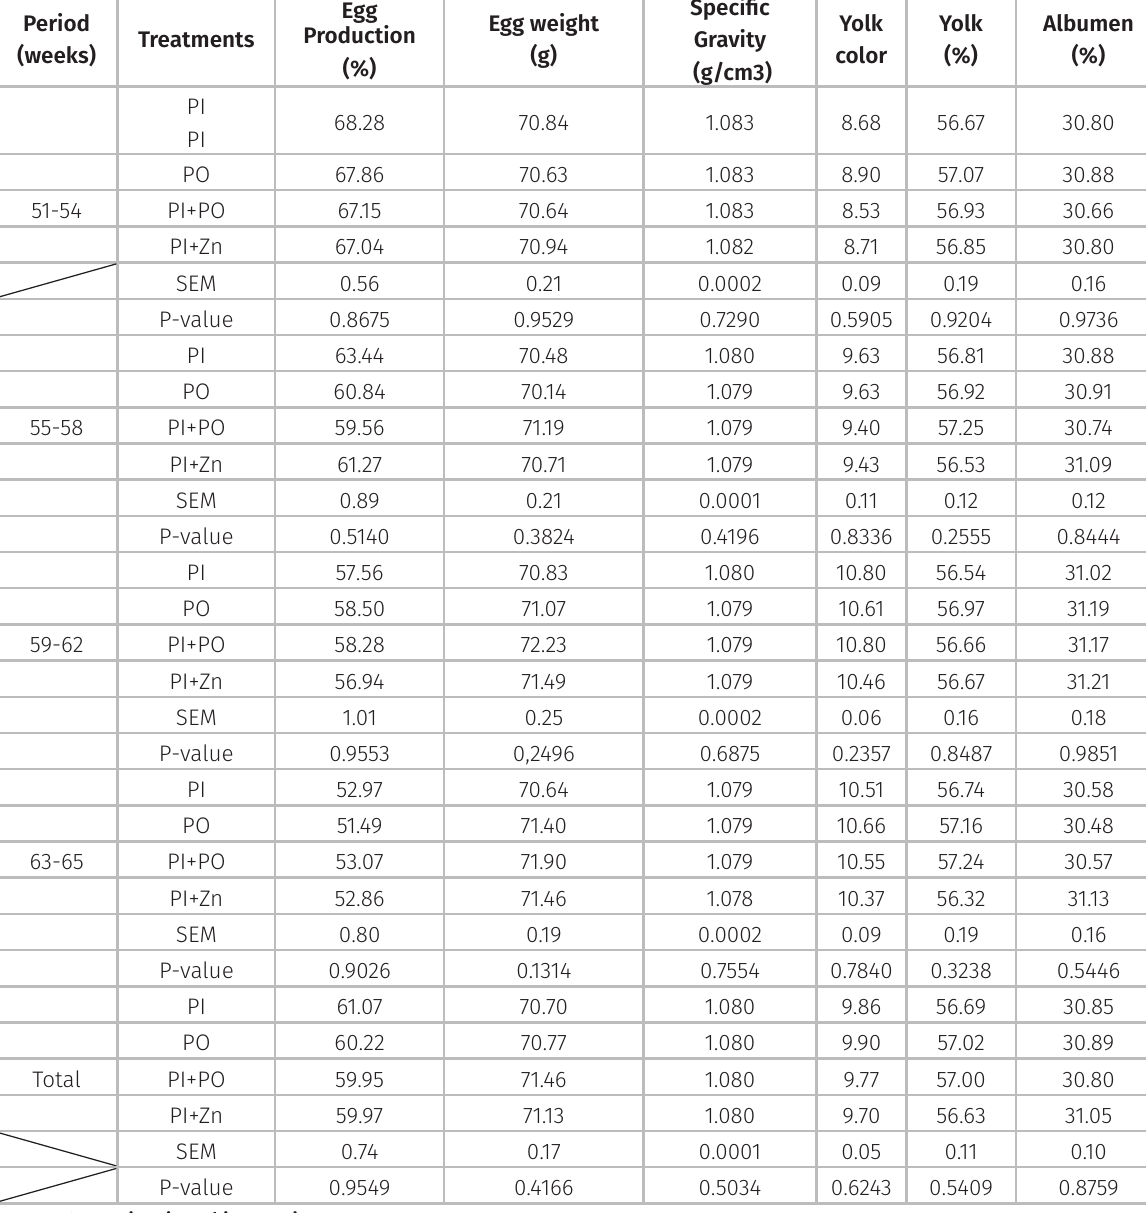
Table III. Egg production, constituents and specific gravity. Period